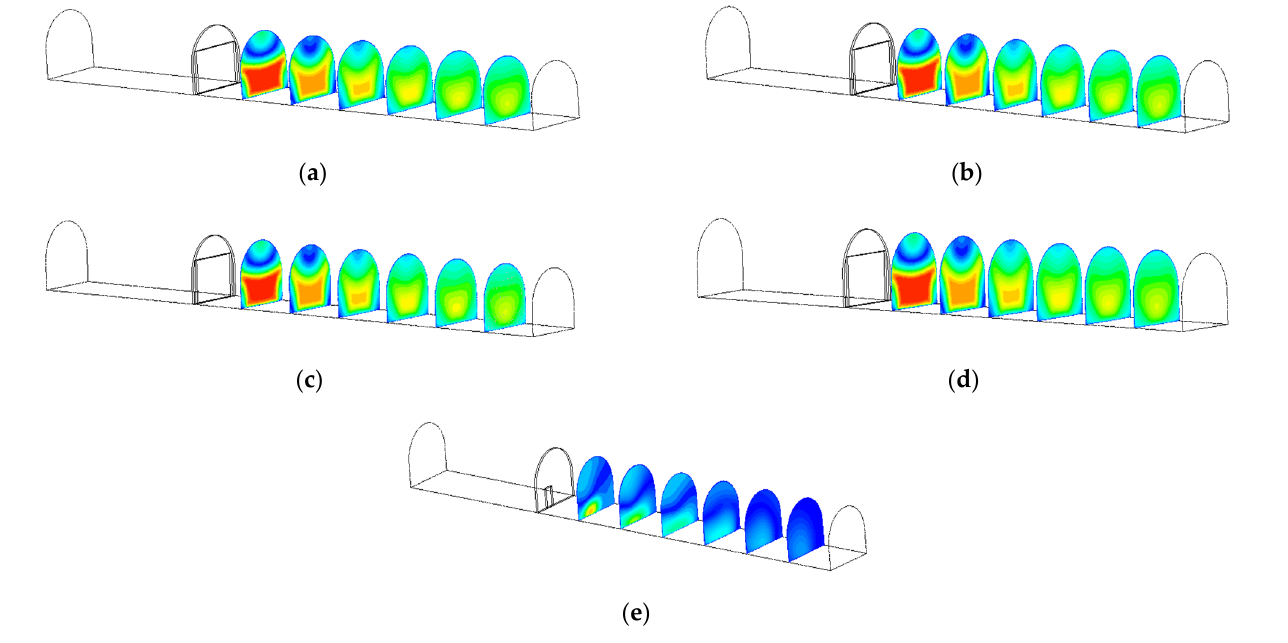
Figure 11. Air speed distribution of the roadway cross-section. ( a ) Air-speed distribution of the roadway cross-section behind the wide door at 2 m/s; ( b ) Air-speed distribution of the roadway cross-section behind the wide door at 4 m/s; ( c ) Air-speed distribution of the roadway cross-section behind the wide door at 6 m/s; ( d ) Air-speed distribution of the roadway cross-section behind the wide door at 8 m/s; ( e ) Air-speed distribution of the roadway cross-section behind the personnel door at 8 m/s.